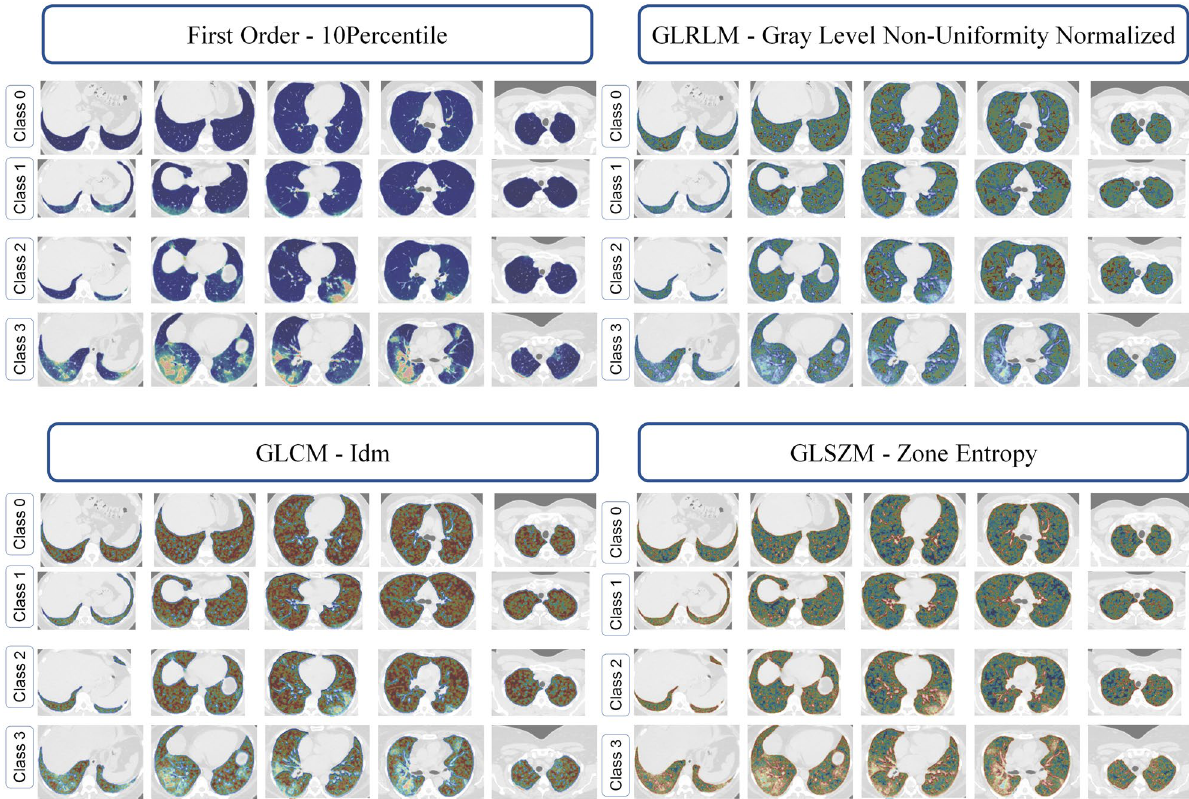
Figure 3. Examples of selected features (10Precentile from first order, Gray level Non-Uniformity Normalized from GLRLM, Idm from GLCM and Zone Entropy from GLSZM) in different class cases and different